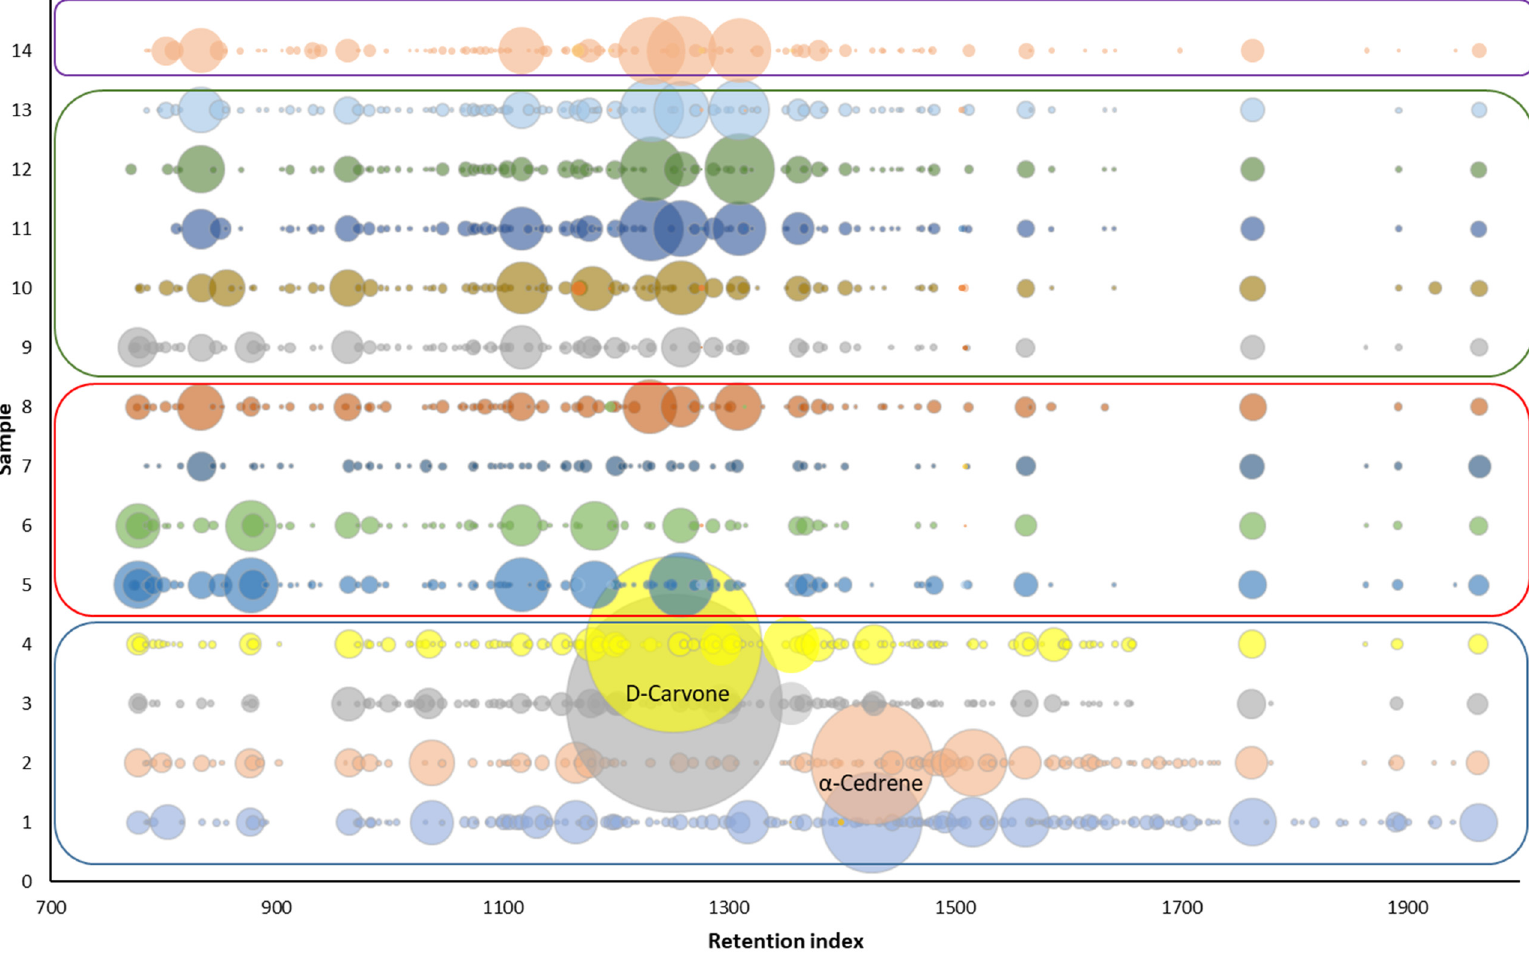
Figure 4. A comparison of the overall aroma profile of samples 1–14 obtained by GC-FID analysis. Blue box—Greek balsamic vinegar; red box—BVM; Green box—“premium“ BVM; purple box—TBVM. Spots represent each peaks of the compounds in chromatogram; the size corresponds to peak area of volatile compounds in chromatogram.